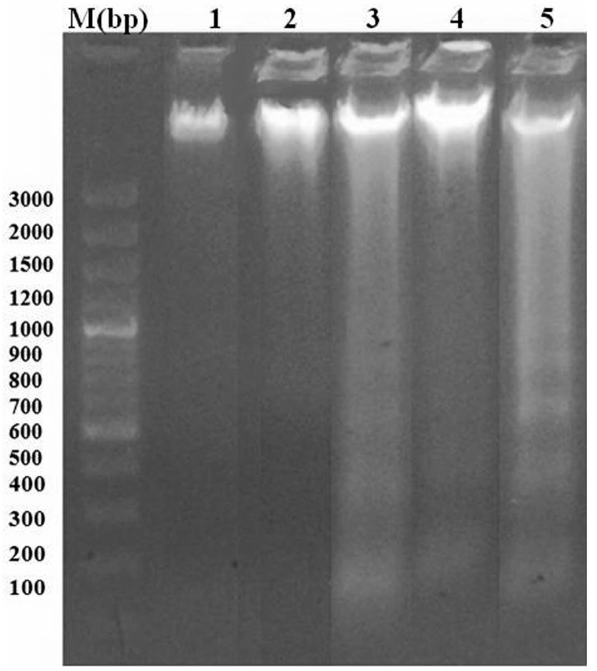
treated group showed 2 treated group 2 treated 2 - 2